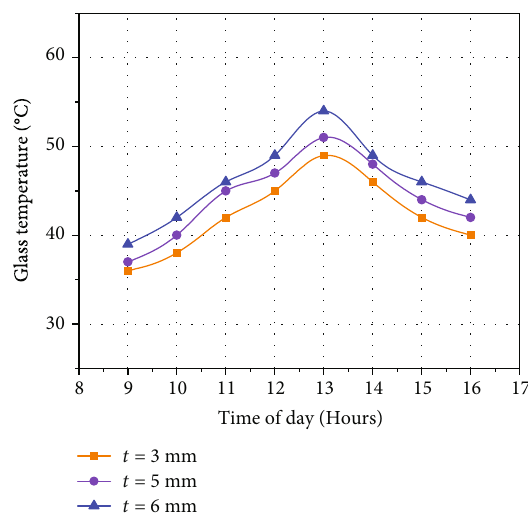
Figure 5: Time-wise fl uctuation of T